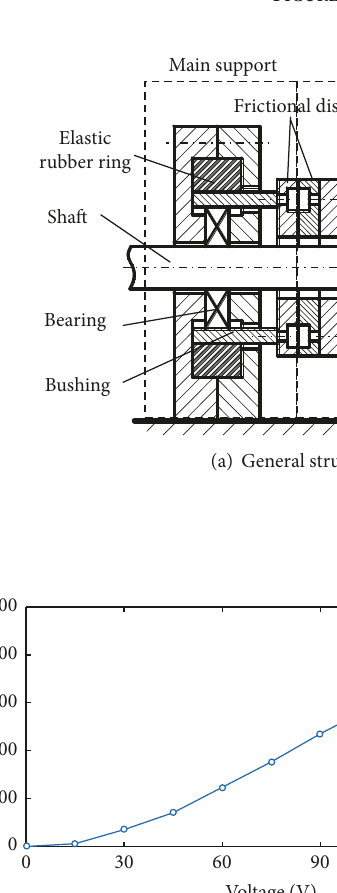
Figure 9: Multispan shaft test-setup with a Smart Spring support.